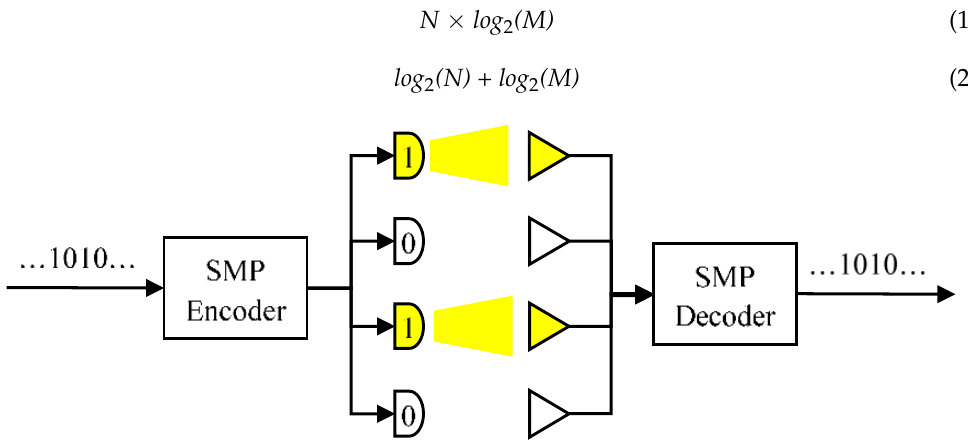
With a fixed number of channels and pulse-amplitude modulation (PAM) levels, SMP provides higher spectral efficiency compared to SM.